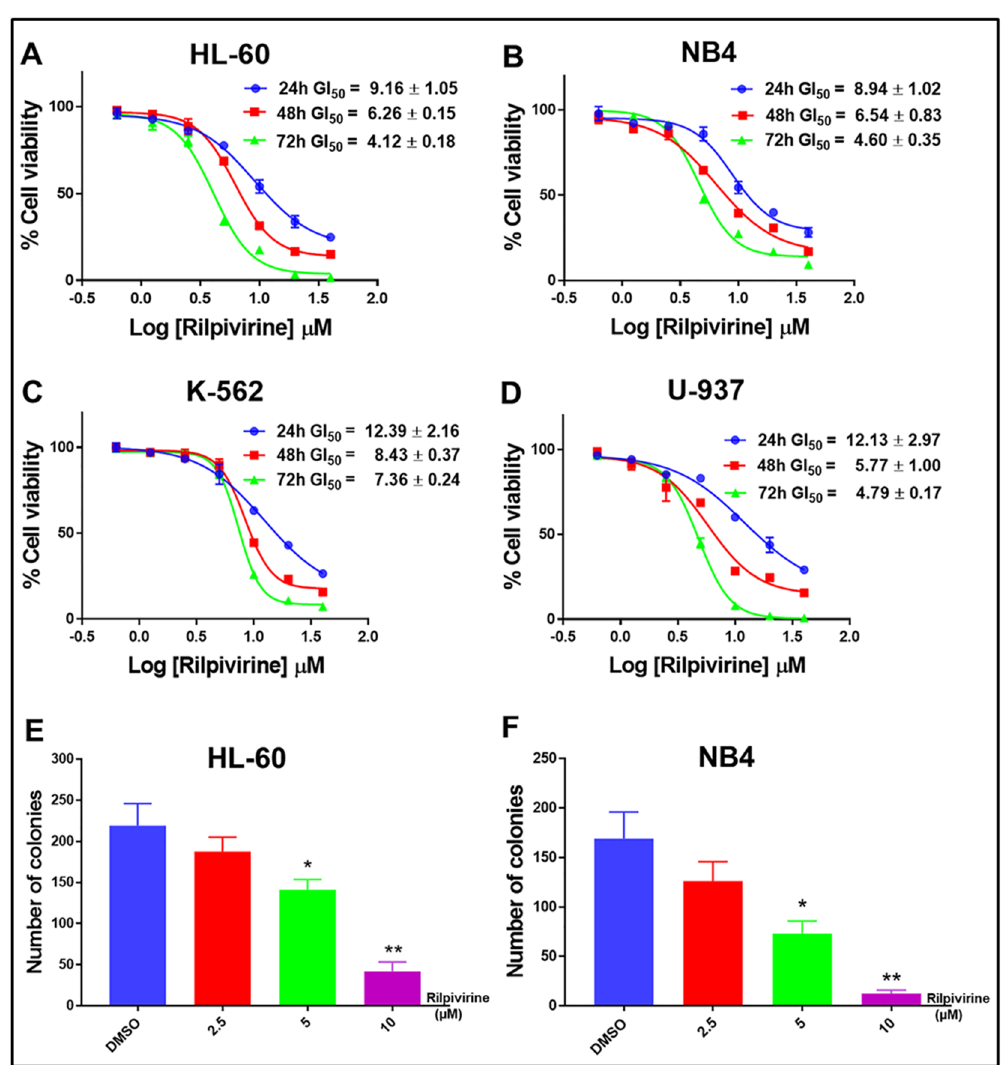
Figure 2. Growth inhibitory profile of rilpivirine against leukaemia cell lines. ( A – D ) Representative dose–response curves with GI 50 values for HL-60, NB4, K-562, and U-937 cells following incubation with rilpivirine for the indicated times. Data (mean ± SD) were presented from at least three replicates. ( E , F ) The effect of rilpivirine on the clonogenicity of HL-60 and NB4 cells. Data (mean ± SD) were presented from at least two independent experiments (* p < 0.05, ** p < 0.01).